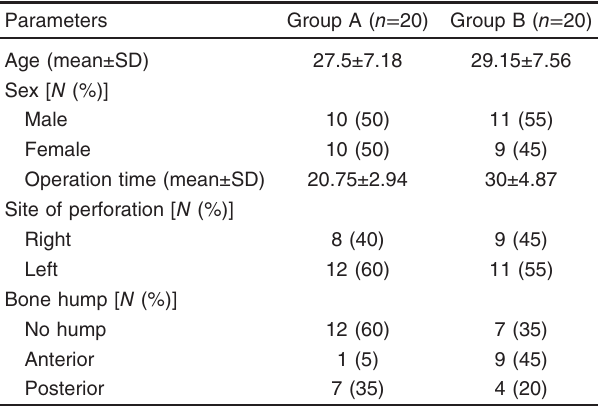
Table 1 Characteristics of the studied